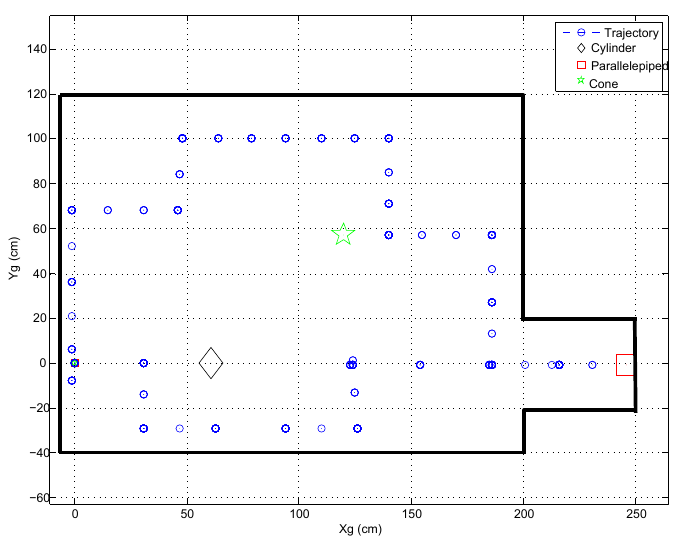
Figure 10. Map of the enclosure with the arrangement of objects within